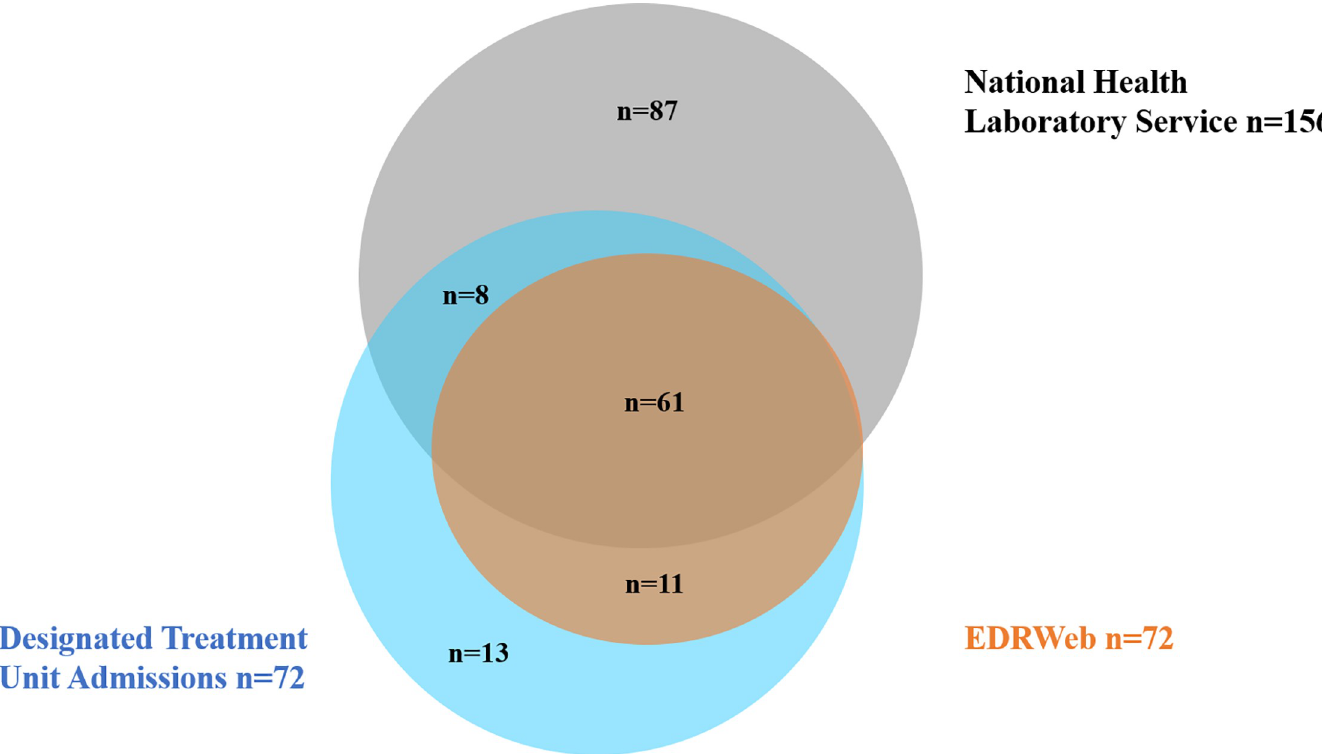
Fig 2. Children ( < 13 years) with MDR TB captured by laboratory, hospital, or disease surveillance systems (N = 180), in three provinces in South Africa, 2008– 2010.